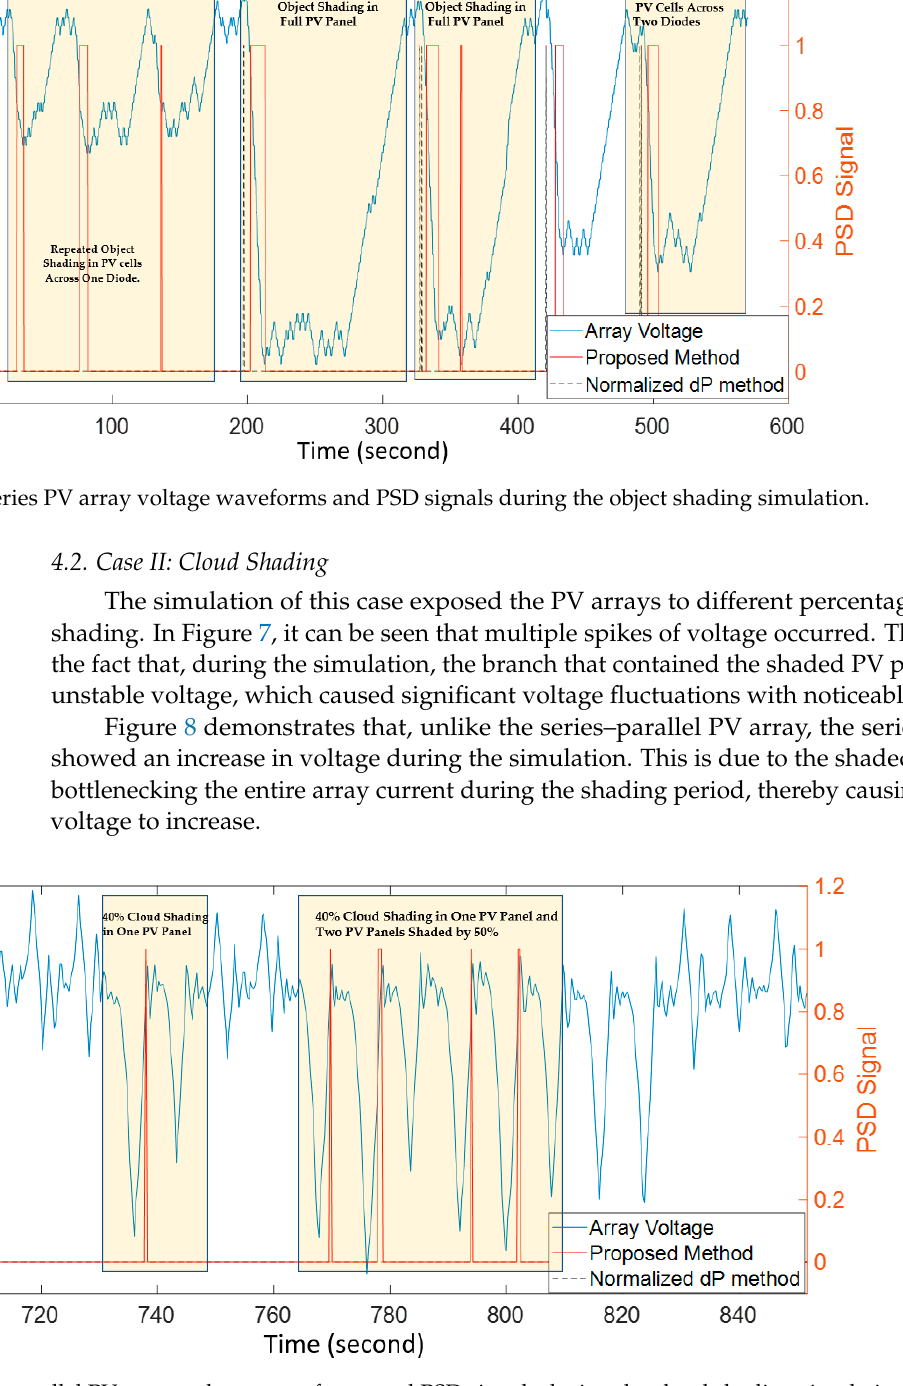
Figure 6. Series–parallel PV array voltage waveforms and PSD signals during the object shading simulation.